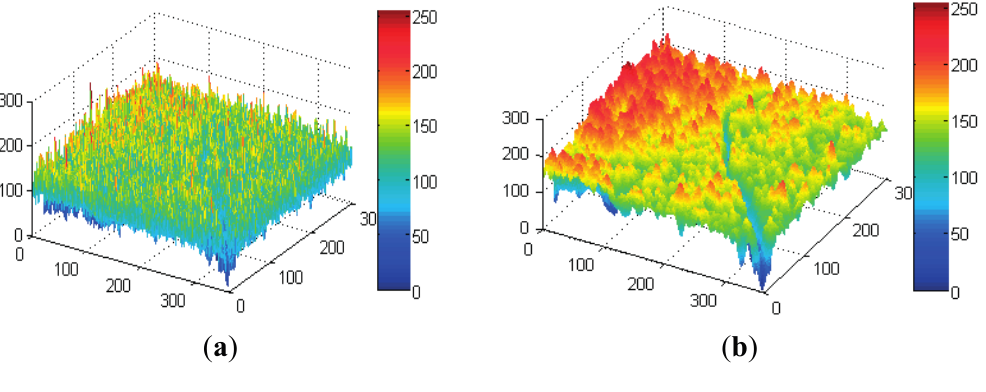
Figure 4. Comparison of original image and smoothed image, with ( a ) original image; ( b ) smoothed